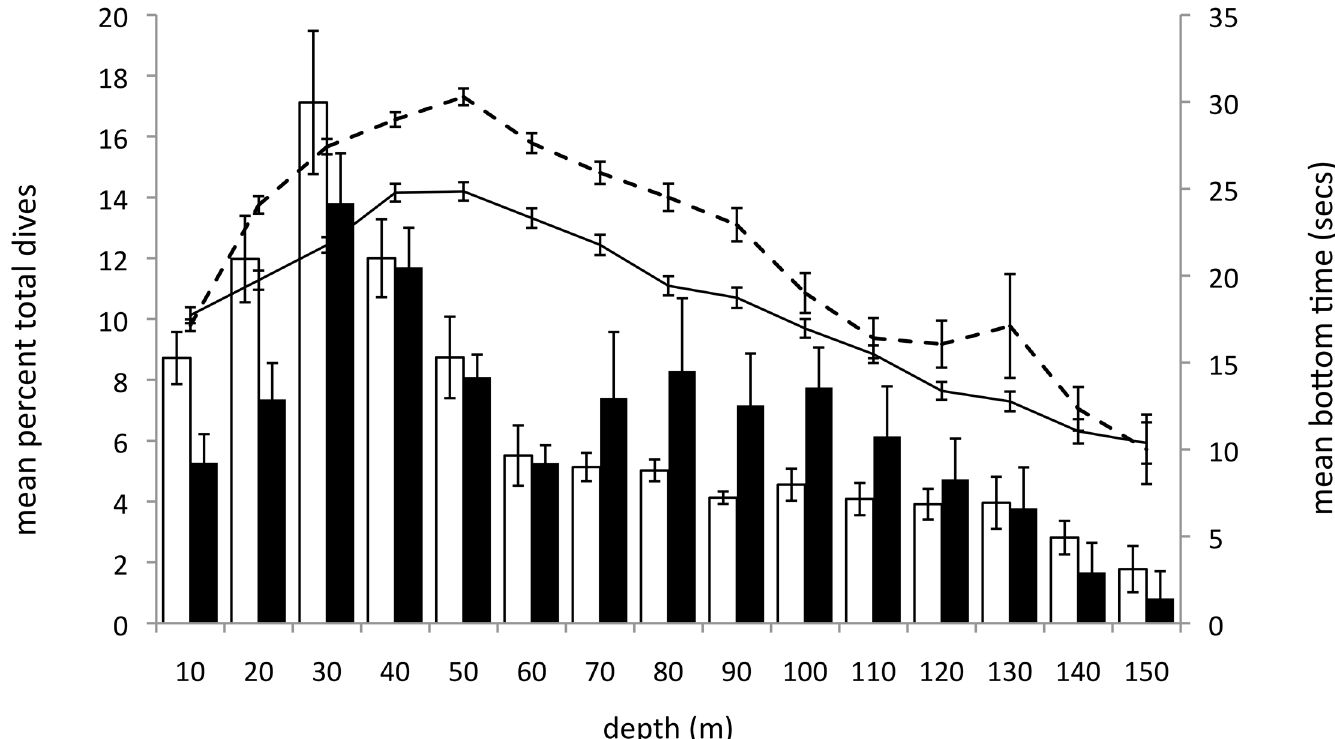
Fig 7. Mean percentage daily number of dives (bars) and mean bottom duration (lines) by 10 m intervals for female (white bars, solid line) and male (black bars, dashed line) murres during